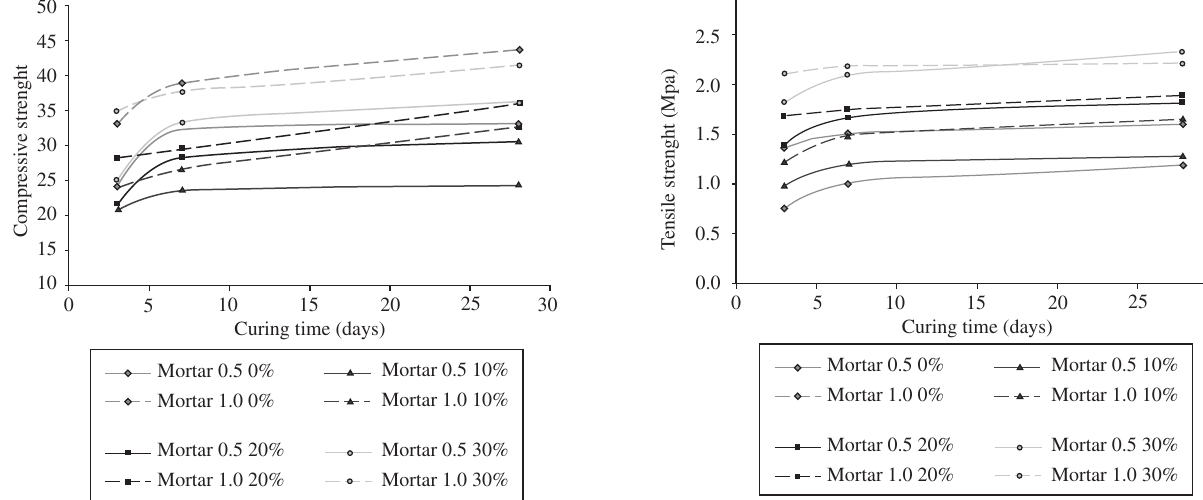
Figure 5. Compressive strength of magnesium phosphate cement mortar as a function of sand and grinding dust